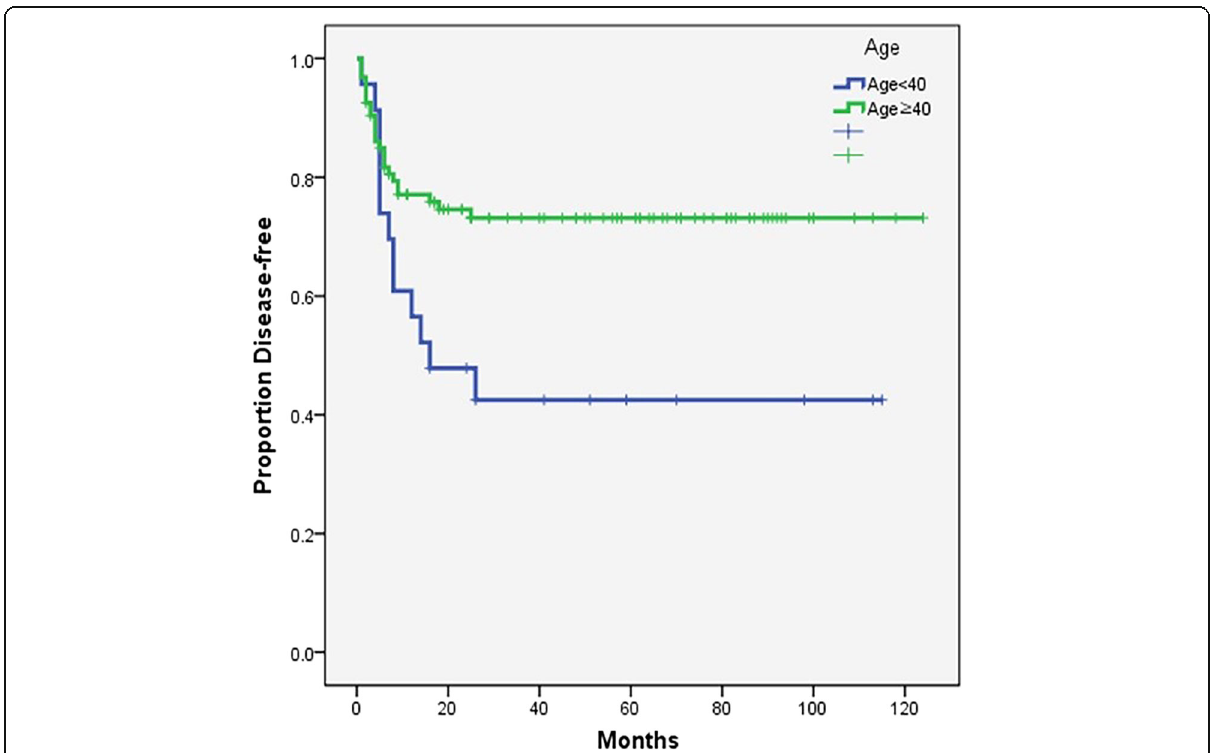
Fig. 2 Kaplan-Meier disease-free survival curve (log-rank p =